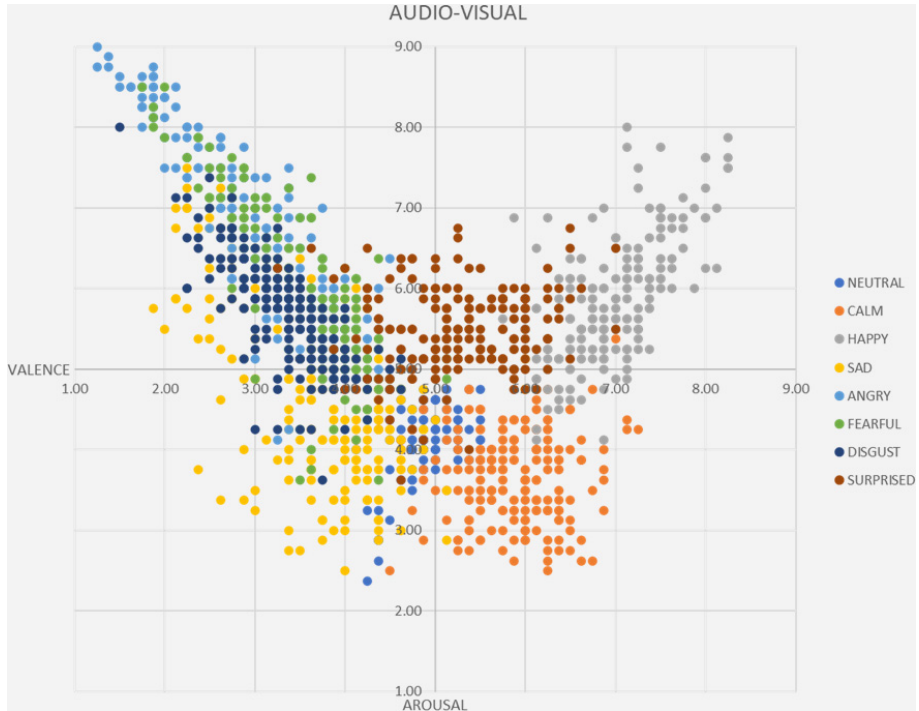
Figure 9 . Emotion classification of eight categories using valence and arousal in two-dimensional space.